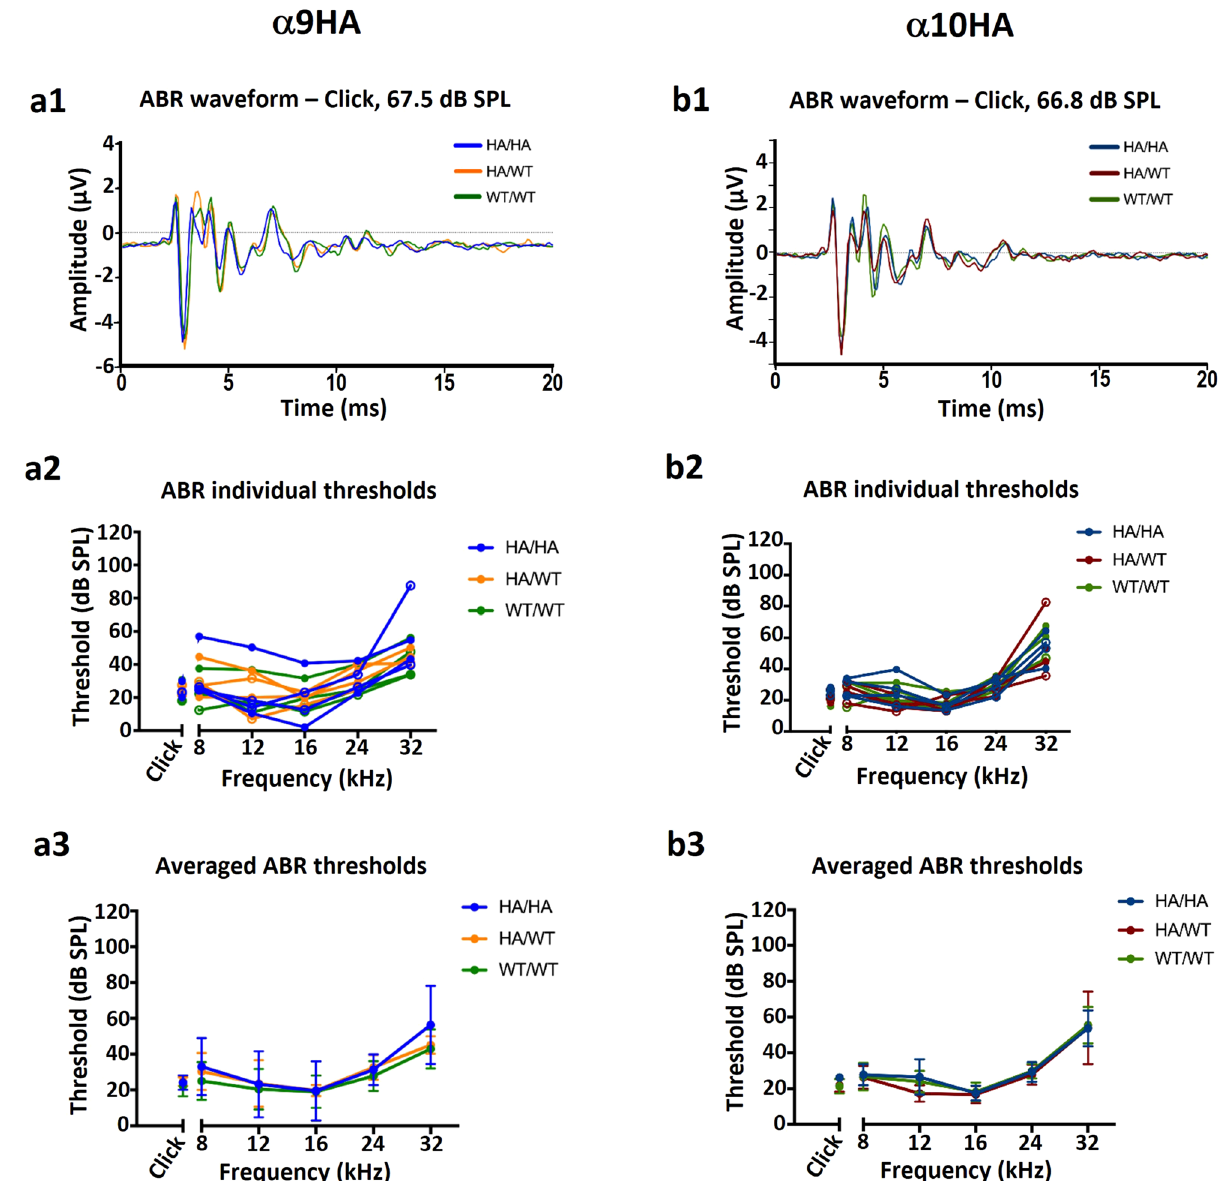
Figure 2. Alpha9HA and α10HA knock-in mice exhibit normal ABRs to both click and pure tone stimuli. Alpha9HA ABR waveform ( a1 ), individual threshold measurements ( a2 ), and average threshold measurements by genotype group ( a3 ). The overlaid ABR waveforms are the average waveforms generated from the click stimulus at 30 dB of attenuation from the maximum stimulus tested, as indicated. Each colored line is the average of 4 mice in that genotype group. N = 4 mice in each group. Averaged thresholds (bottom) were not significantly different among groups when tested with a two-way ANOVA comparing the three genotypes (F(2,53) = 1.15, p = 0.32). Dunnett’s correction for multiple comparisons was applied to the comparisons between each genotype at each frequency; no genotype was significantly different from any other genotype at each frequency. Alpha10HA ABR waveform ( b1 ), individual threshold measurements ( b2 ), and averaged threshold measurements by genotype group ( b3 ). The overlaid ABR waveforms are the average waveforms generated from the click stimulus at 30 dB of attenuation from the maximum stimulus tested, as indicated. Each colored line is the average of 4 mice in that genotype group. N = 4 mice in each group. Averaged thresholds (bottom) were not significantly different among groups when tested with a two-way ANOVA comparing the three genotypes (F(2,53) = 0.8, p = 0.45). Dunnett’s correction for multiple comparisons was applied to the comparisons between each genotype at each frequency; no genotype was significantly different from any other genotype at each